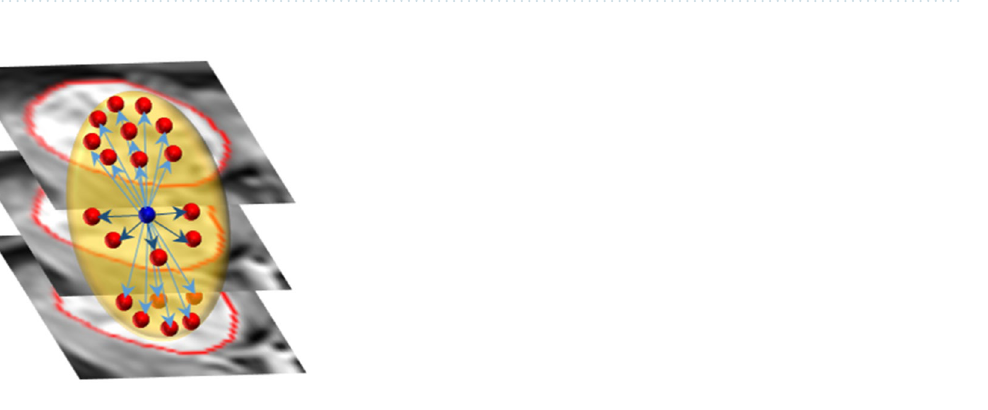
Figure 7. Visualization of rotation invariant neighborhood system of the center voxel (blue) to construct